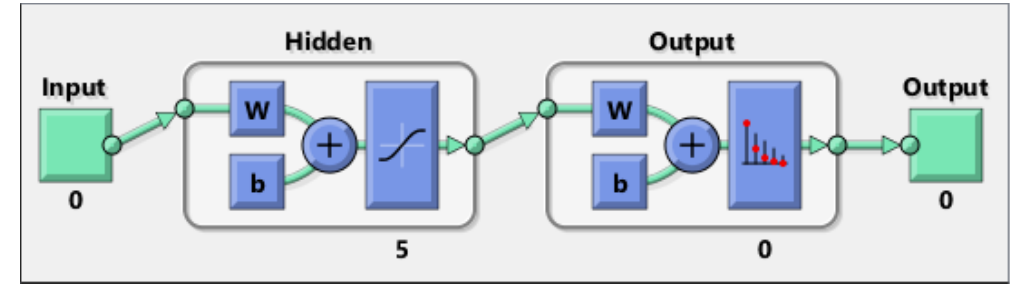
Figure 7. Neural network created.